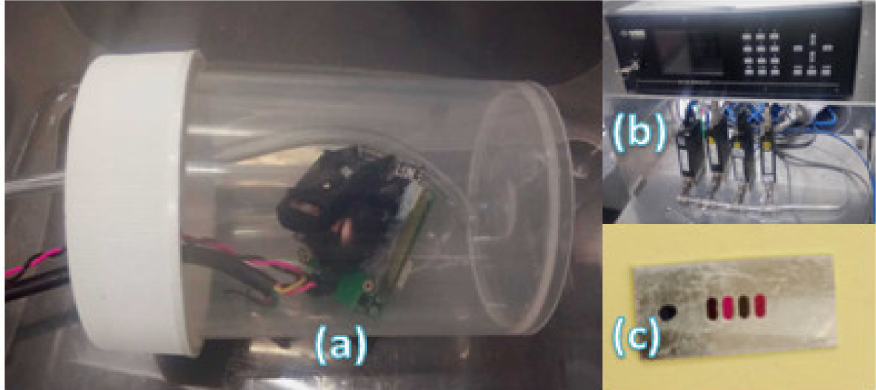
Figure 14. ( a ) Gas sensor custom-built chamber; ( b ) Mass Flow Controllers for gas mixing; ( c ) Aluminium-based filter array holders for testing fixed-line passband filters.